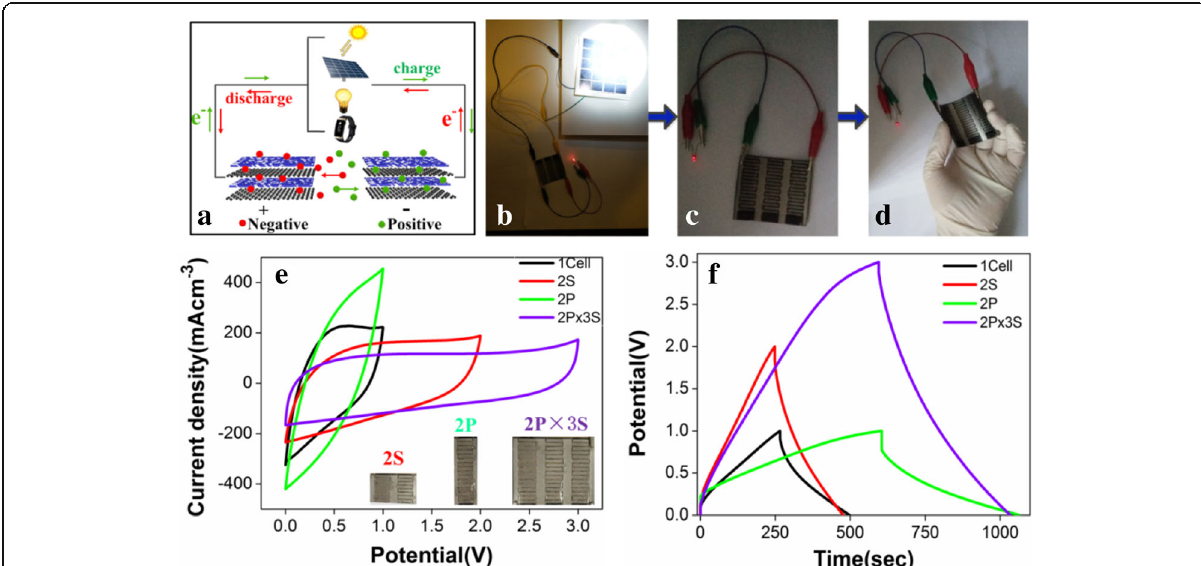
Fig. 7 Fabrication of rGO/PEDOT-50-based MSC array as micro-energy storage devices. a Schematic of showing the working principle of MSC array integrated with miniaturized electronic devices. b ~ d Integration of a flexible MSC array with solar cells for lighting a LED. e The CV curves at 20 mV s − 1 and f GCD curves at 40 mA cm − 3 of MSC array connected in series (2 cells in series, 2S), in parallel (2 cells in parallel, 2P), and in a combination of series and parallel (2 parallel × 3 series, 2P × 3S). The optical images of MSC array insert in